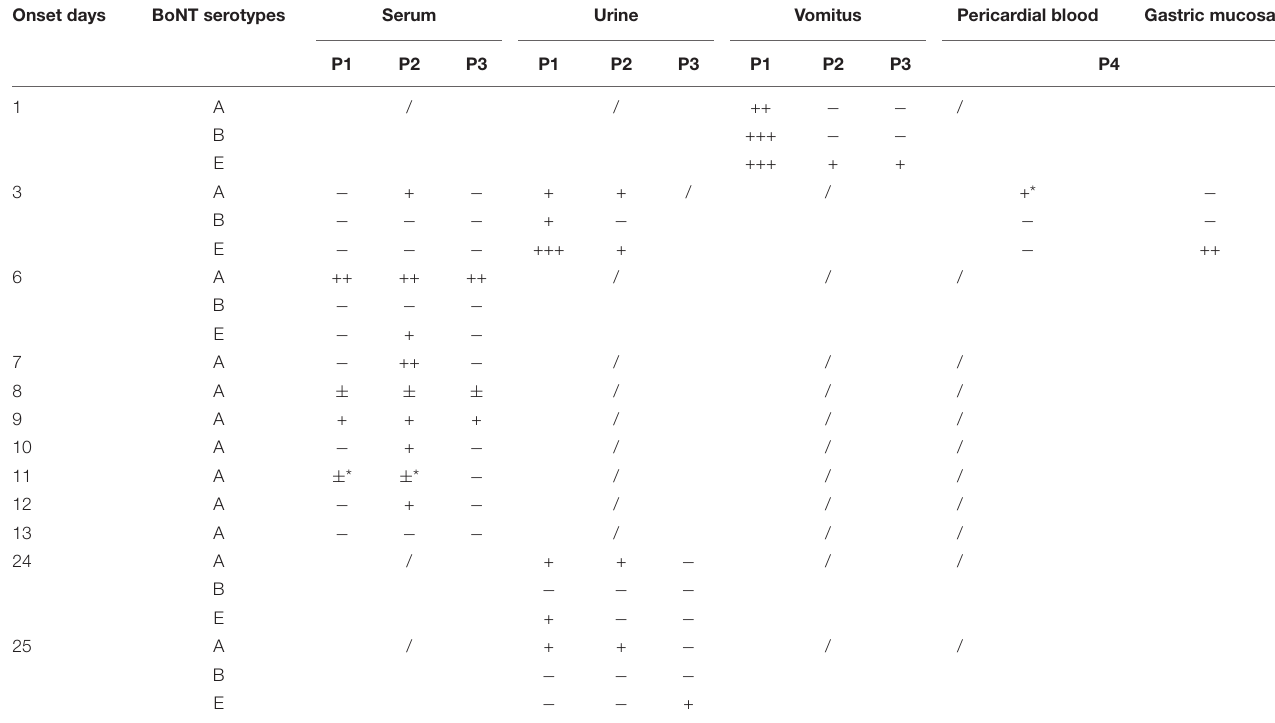
TABLE 3 | BoNT/A, B, and E detection results in serum, urine, vomitus, and anatomical samples of Patients 1–4. Onset days BoNT serotypes